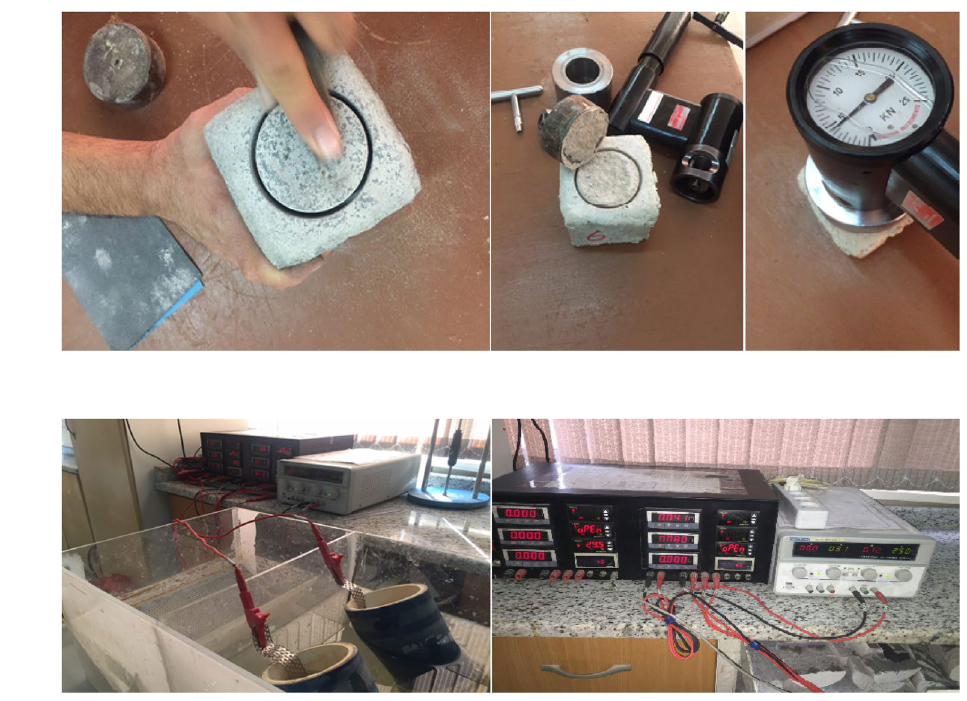
Fig. 4 The pull-off device applied in this study